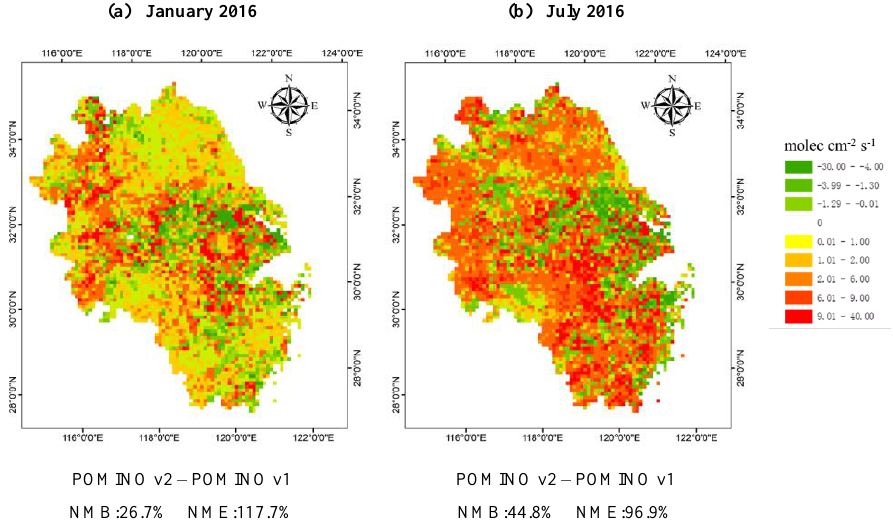
Figure 4. The spatial differences (POMINO v2 - POMINO v1) of top-down NO X emissions derived from POMINO v2 and POMINO v1 in January and July